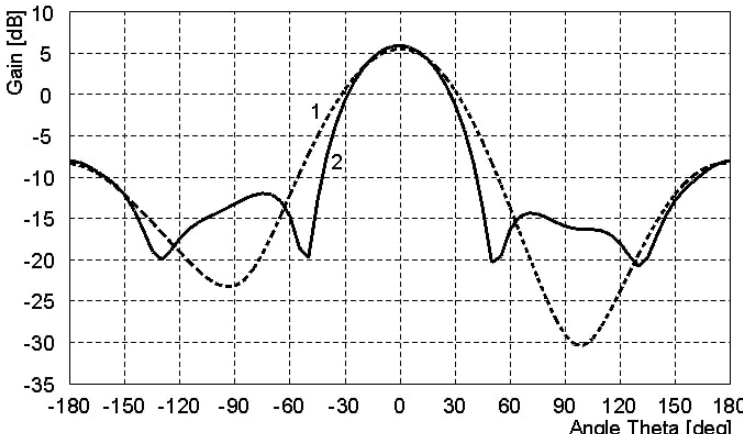
Figure 13. Directional diagram of a three-element antenna array (curve 1—in − phase excitation, 2—non − in − phase excitation) [70].